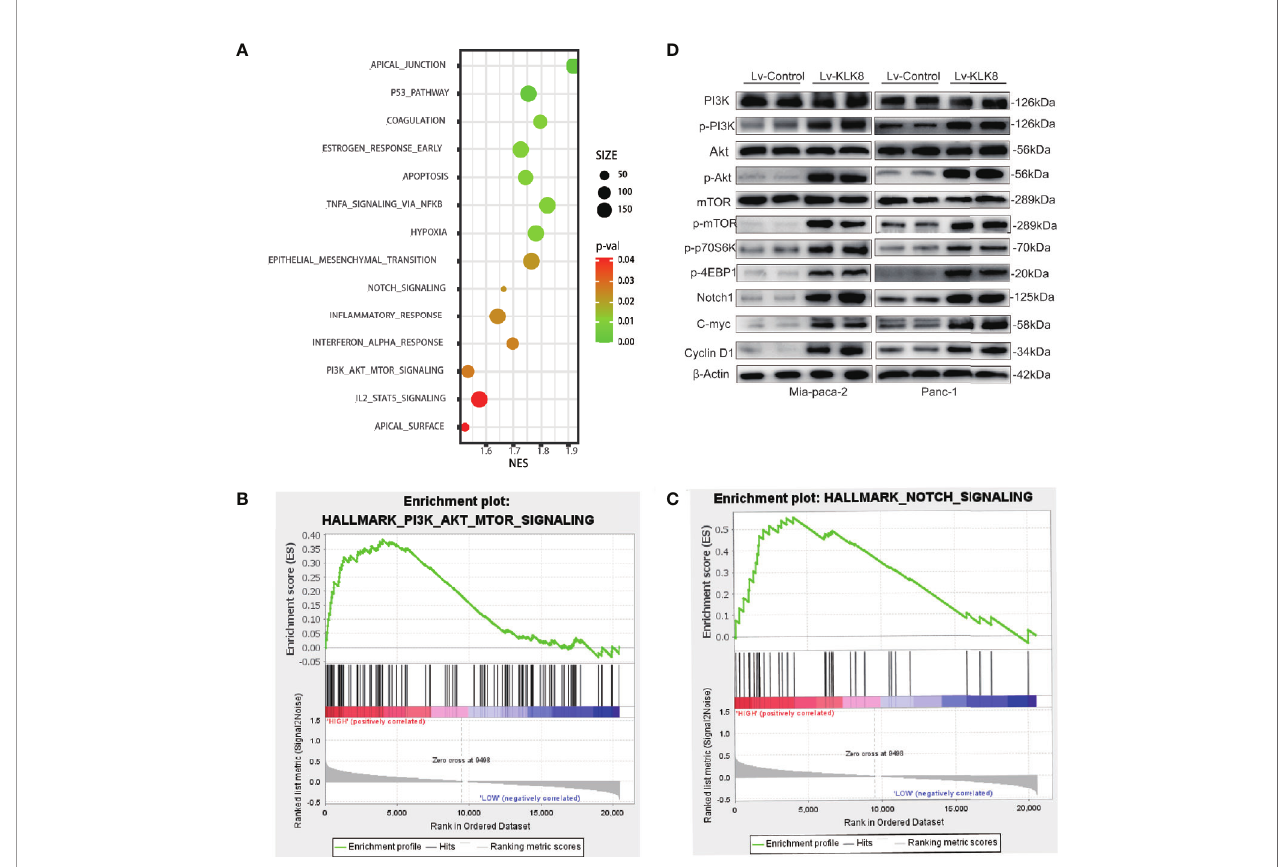
FIGURE 5 | Signi fi cantly-altered pathways were predicted in PDAC and veri fi ed in KLK8-overexpressed pancreatic cancer cells. (A) Gene sets enriched in the transcriptional pro fi les of tumors belonging to the top KLK8 high-expression group, compared with the bottom-expression group in the TCGA dataset. Shown are the NES (normalized enrichment score) values for each pathway using the Hallmark gene sets. The functional annotations of KLK8 positive and negative expression in PDAC was predicted. A nominal p value of <0.05 is considered statistically signi fi cant. (B, C) GSEA highlighted positive association of increased KLK8 expression levels with PI3K-Akt-mTOR (B) and Notch (C) signal pathways. (D) levels of key proteins in PI3K-AKT-mTOR and Notch signaling pathways were examined in KLK8- overexpressed Mia-paca-2 and Panc-1 cells using western blot. NES = normalized enrichment score.